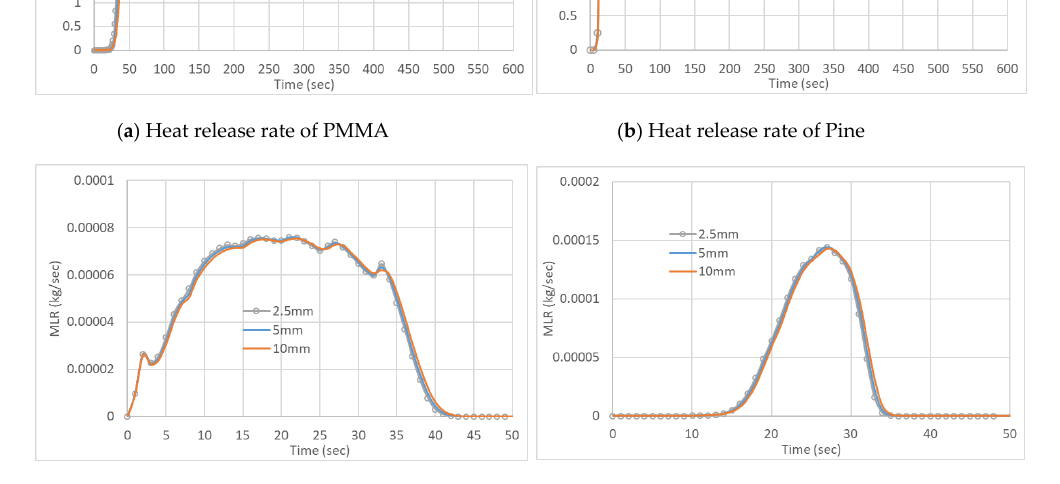
Figure 4. Gas-phase grid convergence analysis.